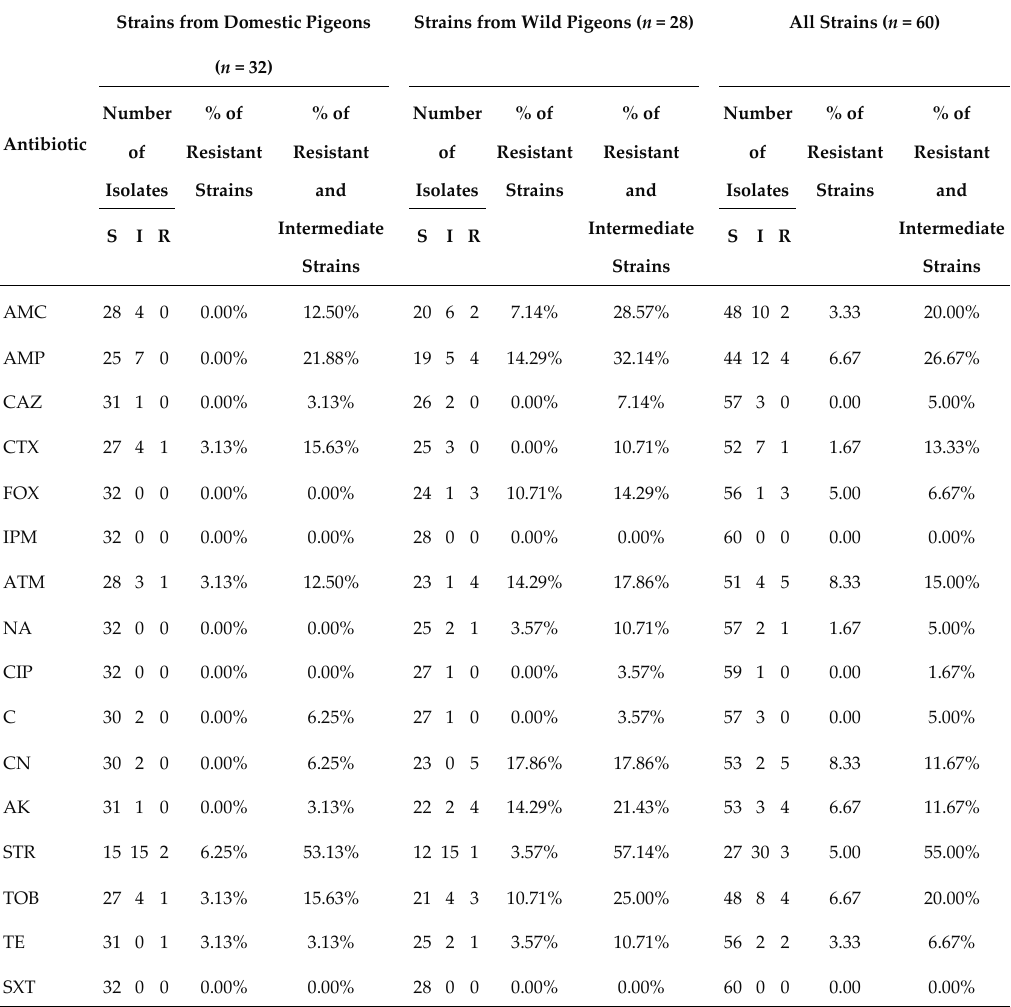
Table 3. Number and percentage of Escherichia coli strains susceptible, intermediate or resistant to each antibiotic tested.